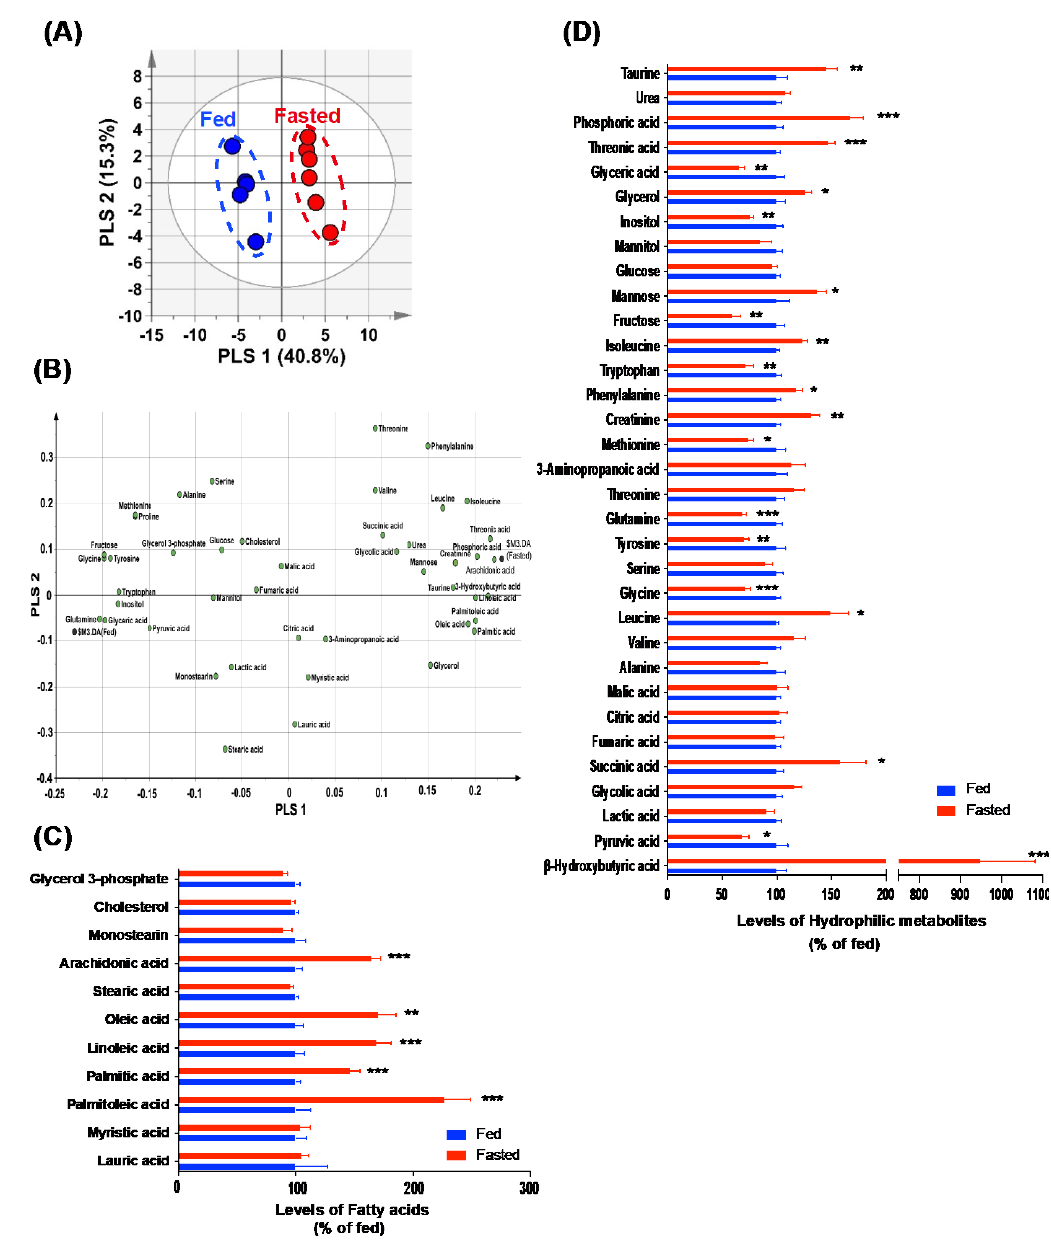
Figure 1. Metabolic profiling in the serum of fasted mice. Levels of serum metabolites were measured in control and fasted mice using GC − MS. ( A ) Score and ( B ) loading plots of the PLS − DA model were obtained from 44 metabolites. ( C ) Most fatty acids displayed higher levels in the serum of fasted mice, compared to those in the serum of control mice. ( D ) A normalized graph showing altered hydrophilic metabolites in the serum of fasted mice, compared to those in the control mice. Data are presented as the mean ± SEM. n = 5 mice in the control group and n = 6 in the fasted group. * p < 0.05, ** p < 0.01, *** p <